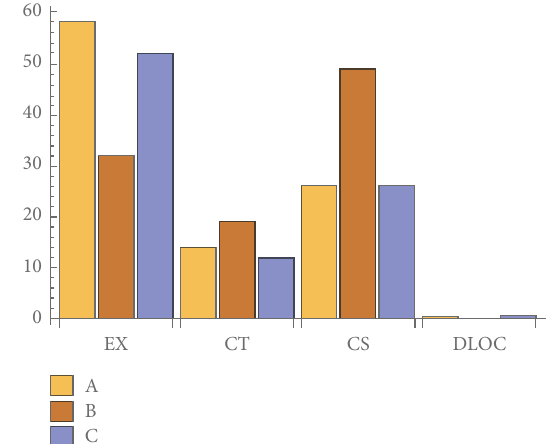
Figure 3: Histogram plot of the populations of adiabatic states in systemsA,B,andCtakeneveryfs.Eachclusterrepresentsadifferent classification of the adiabatic states as shown in Figure